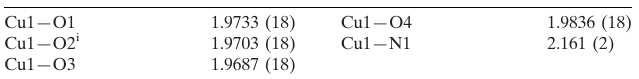
Selected bond lengths (A˚ ).